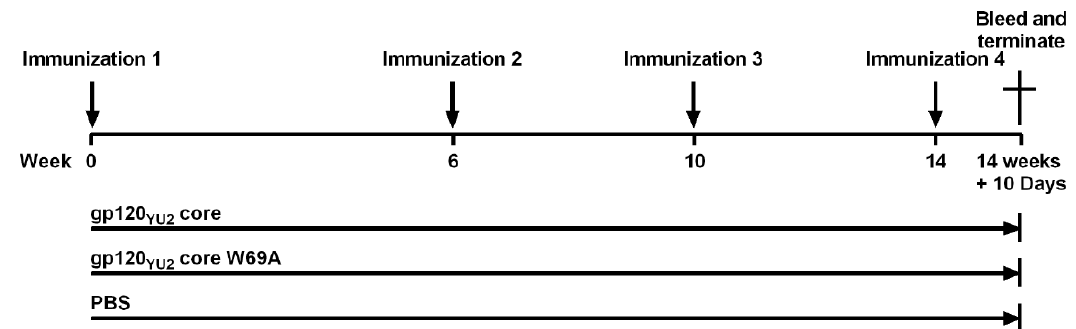
Figure 1. Guinea pig immunization protocol. Groups of six guinea pigs were immunized with each immunogen. A 25- µ g sample of purified gp120 core or gp120 core W69A (or equivalent volume of phosphate-bu ff ered saline (PBS)) was emulsified with AS02A adjuvant in a final volume of 0.5 mL and used to inoculate each animal intramuscularly. Supplemental immunizations were given 6, 10, and 14 weeks after the initial immunization. Blood samples were collected from each animal 10 days after the last immunization.